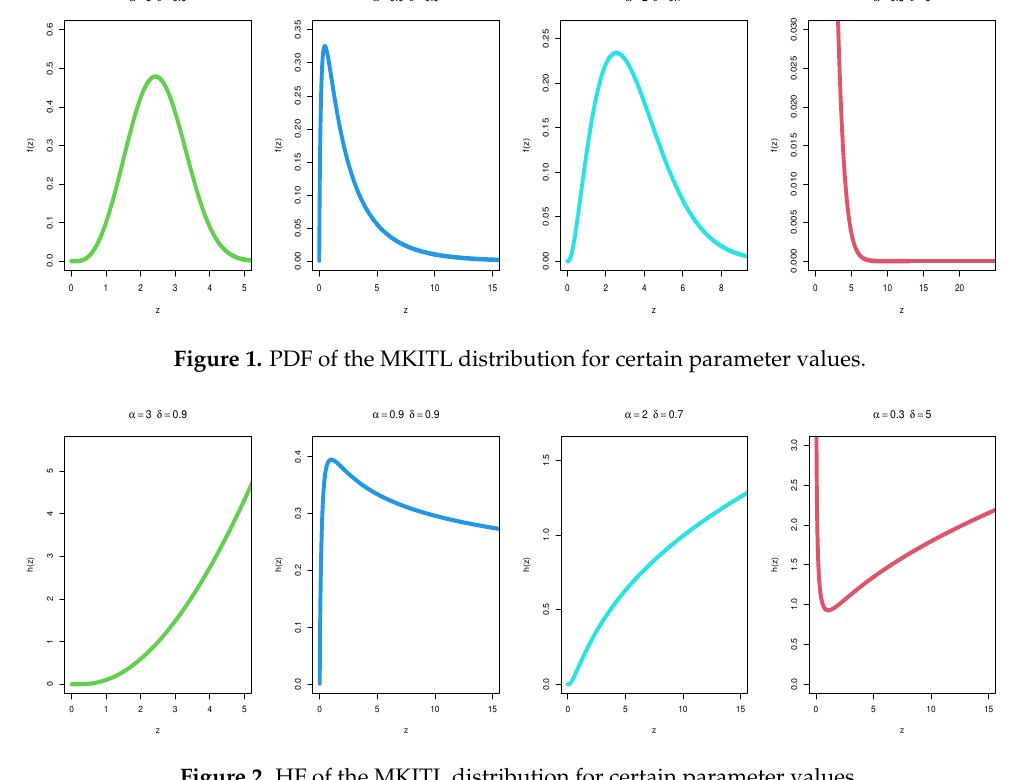
Figure 2. HF of the MKITL distribution for certain parameter